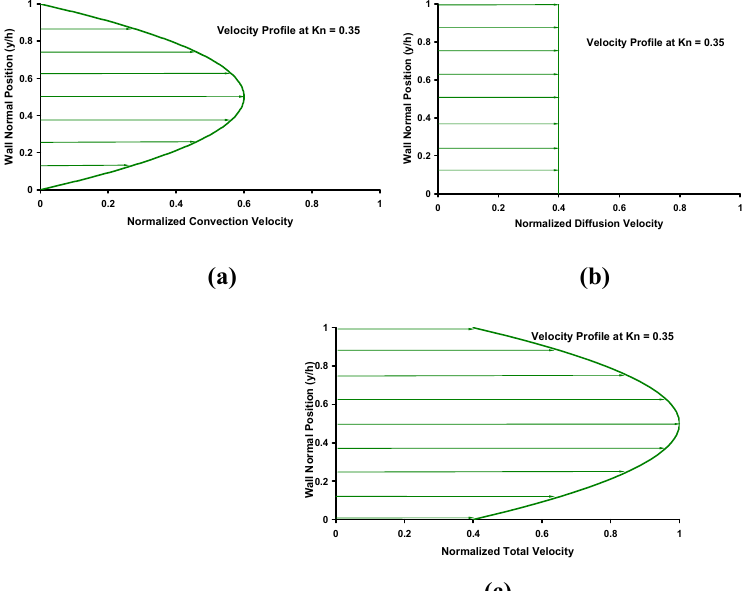
Fig. 4: Normalized velocity distributions: convection (a), diffusion (b) and total (c) velocities at the outlet of the micro-channel for Kn